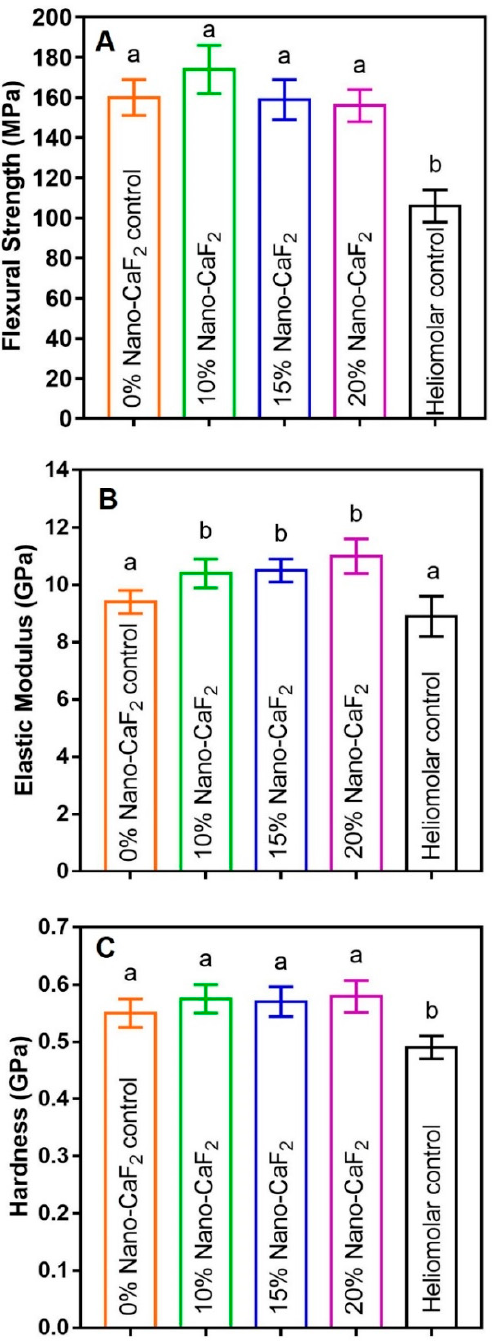
Figure 1. Flexural strength, elastic modulus and hardness of composites. ( A , C ) showed that there was no difference in flexural strength and hardness among the four Nano-CaF 2 groups, but the flexural strength of Heliomolar was less than the others ( p < 0.05). ( B ) The elastic moduli for 0% Nano-CaF 2 and Heliomolar group were slightly less than other Nano-CaF 2 groups. Values with dissimilar letters such as a and b are significantly different ( p < 0.05, mean ± SD; n = 6).